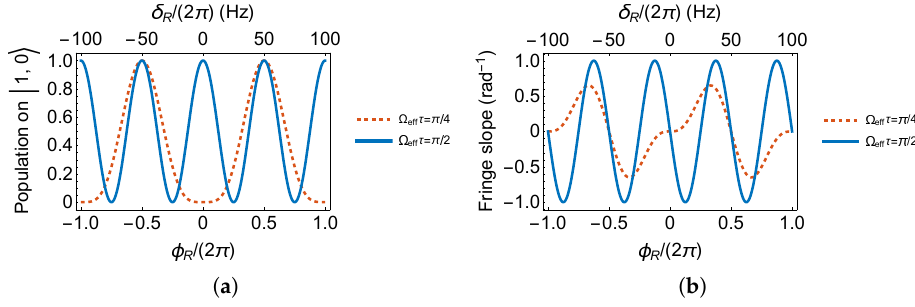
Figure 4. ( a ) Ramsey fringes and ( b ) its slopes on | 1,0 (cid:105)